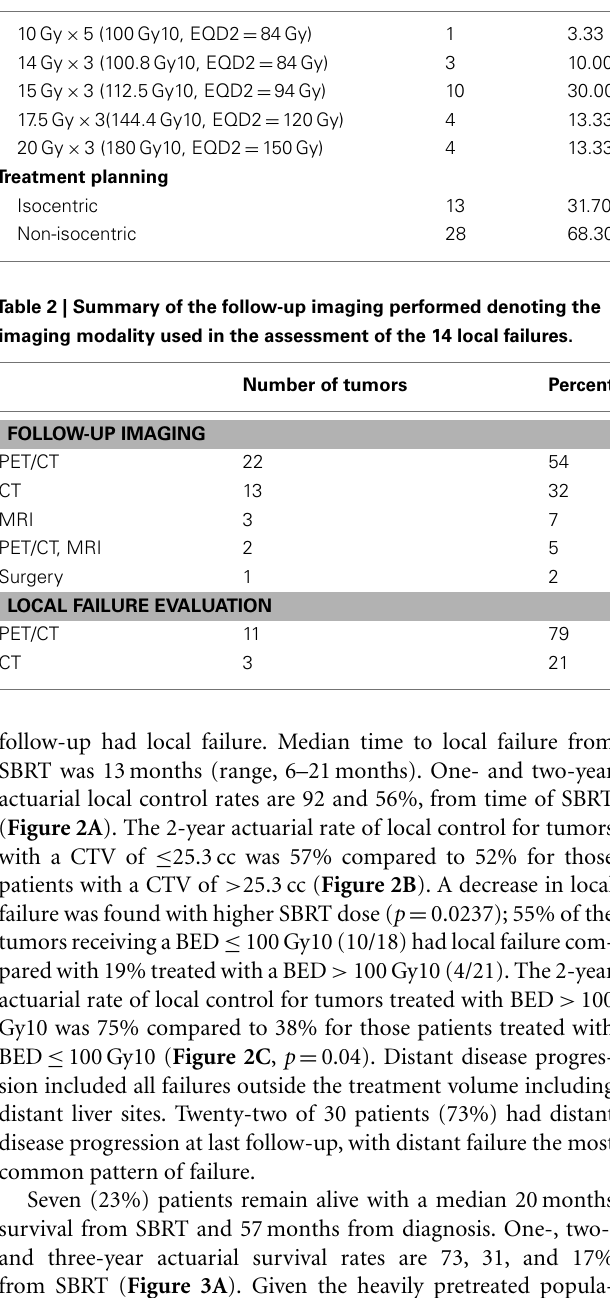
Table 1 | Patient characteristics and treatment parameters.